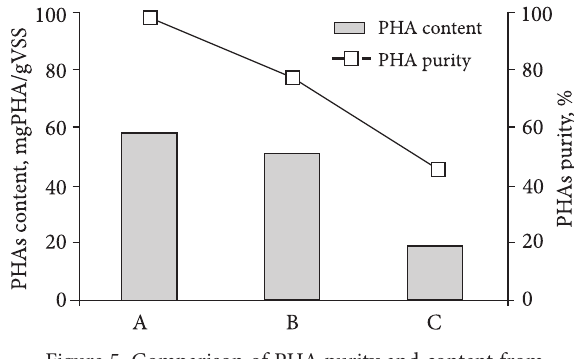
Figure 5. Comparison of PHA purity and content from different sludge sources (A: Municipal Wastewater, B: Husbandry Industry Wastewater, C: Fermentation Industry